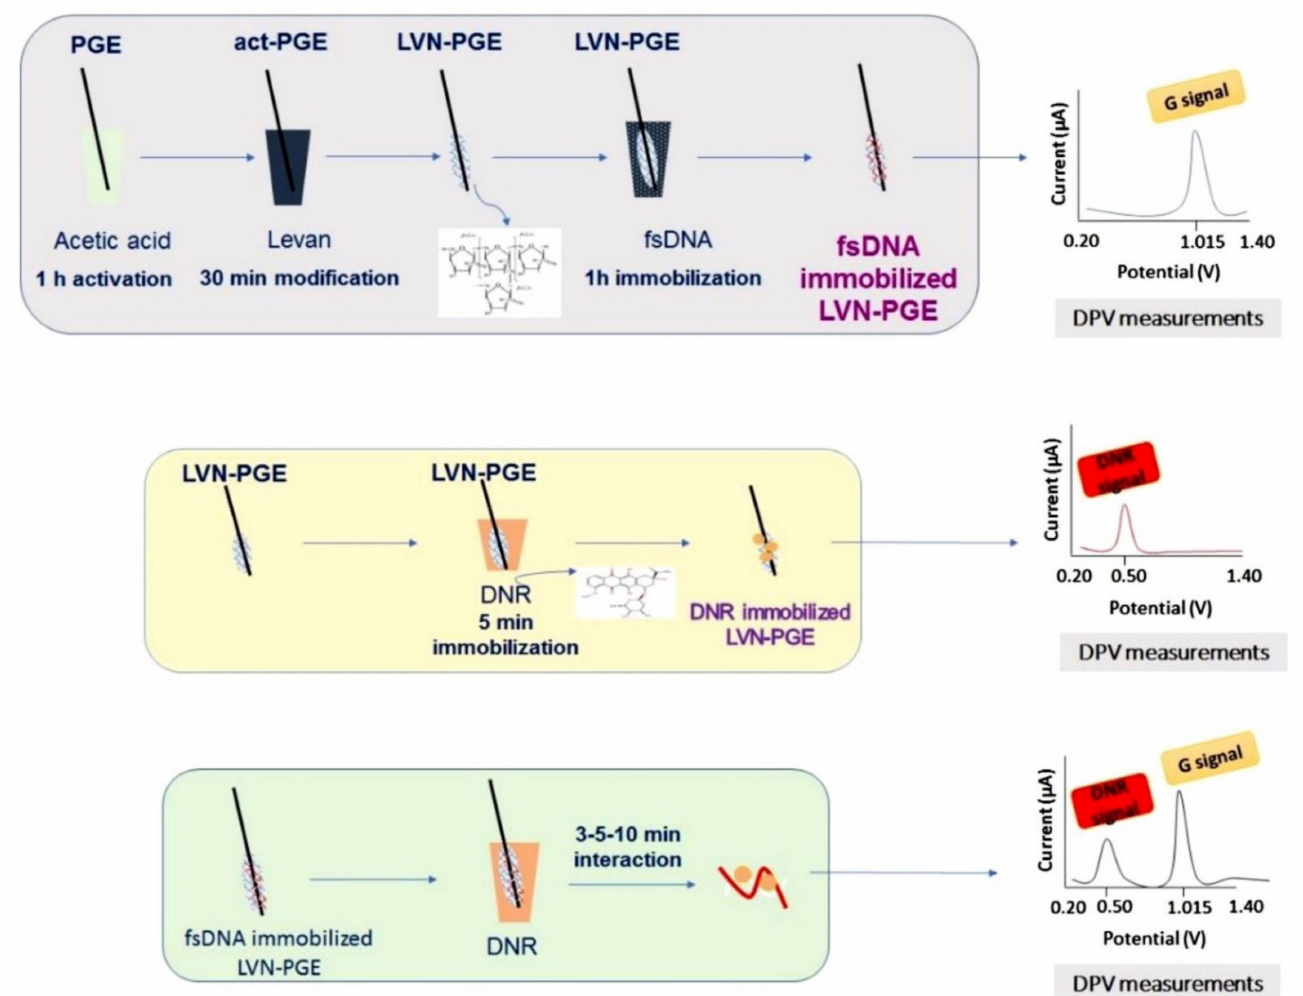
Figure 8. The experimental steps of the modification of LVN at the PGE surface, voltammetric determination of fsDNA and DNR using LVN-PGE and the voltammetric analysis of the biomolecular interaction between fsDNA and DNR at the LVN-PGE surface. Figure adapted from the reference [56] with permission from